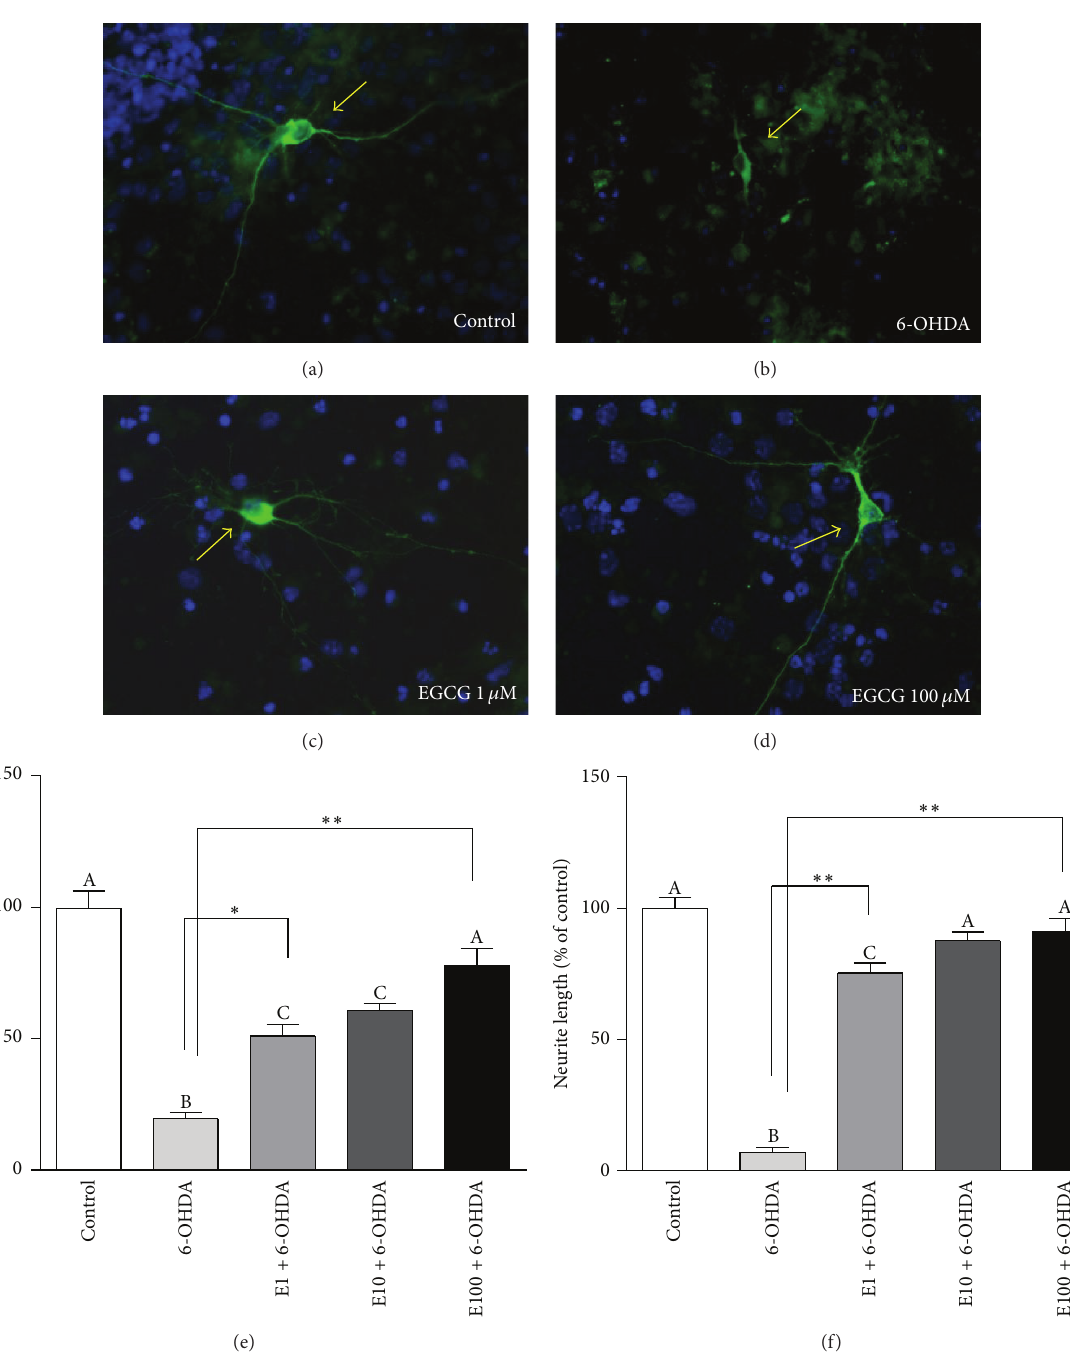
Figure 2: Prevention of TH + neuronal loss by EGCG induced by 6-OHDA in primary cultures. Cells were pretreated with EGCG (1, 10, and 100 𝜇 M) for 2 h followed by 6-OHDA (10 𝜇 M) for 24 h. Immunocytochemistry was used to measure the TH + cells (arrow, (a), (b), (c), and (d)). Quantification data on TH + number (e) and neurite length (f). Values are mean ± SEM, 𝑛 = 3 . Bars without common letters differ. ∗ 𝑝 < 0.01 ; ∗∗ 𝑝 < 0.0001